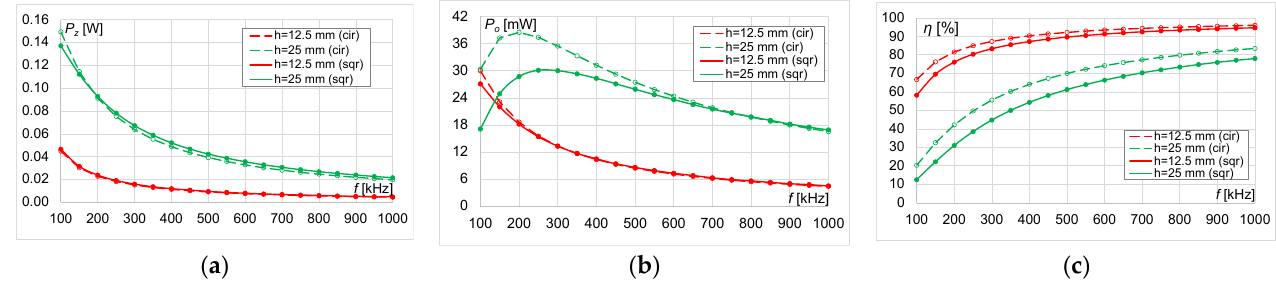
Figure 15. Results for circular and square coils with r = 25 mm and number of turns n = 70 at different distances ( h = 12.5 mm and h = 25 mm): ( a ) transmitter power, ( b ) receiver power and ( c ) power transfer efficiency.